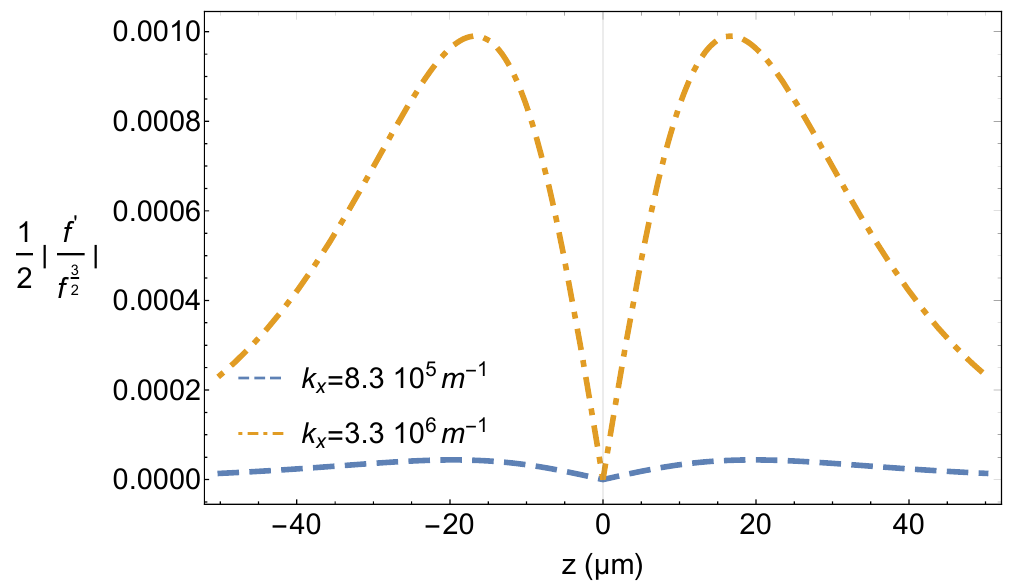
Figure 4. Validity of the WKB approximation 1/2 | f (cid:48) / f 3/2 | << 1 vs the spatial coordinate z for b 0 = 30 µ m, q = 5.9 · 10 6 m − 1 and the values of k x indicated. All the values are the same as in Figures 2 and